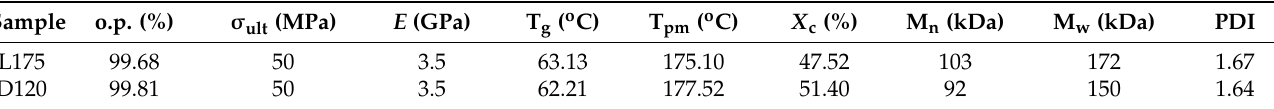
Table 2. Material properties of the TotalEnergies Corbion standard grades of